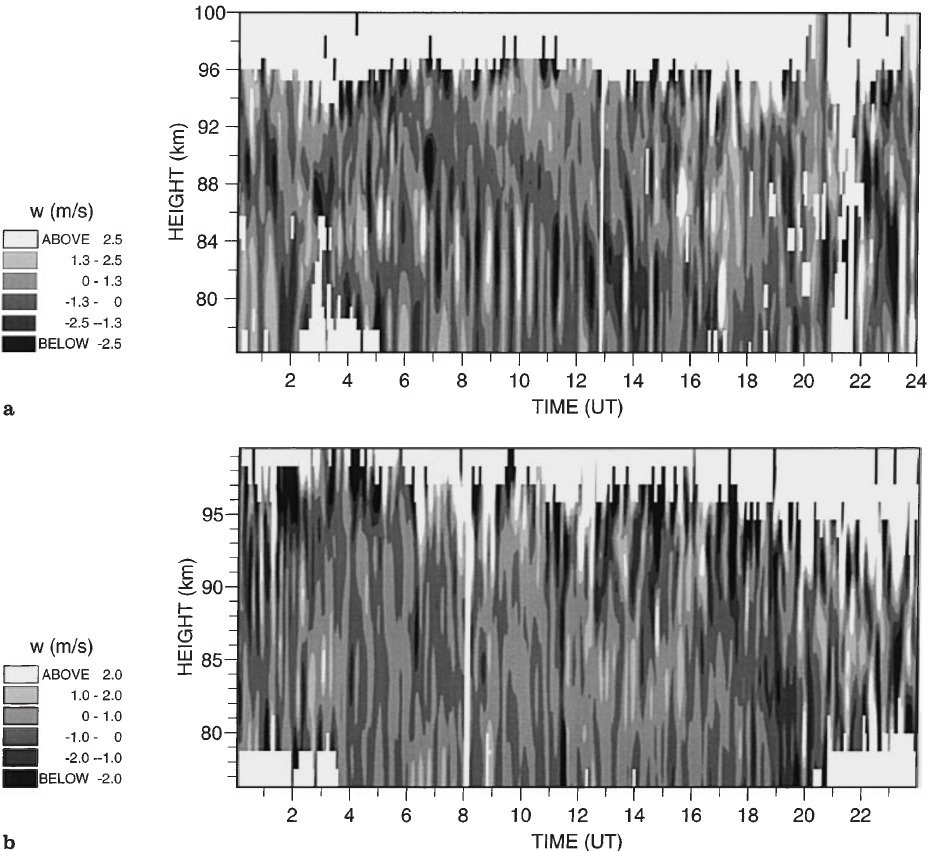
Fig. 1. Time-height contours of vertical velocity for data recorded on a 31 July, 1992, and b 18 March, 1991. Note the di(cid:128)erent velocity scales